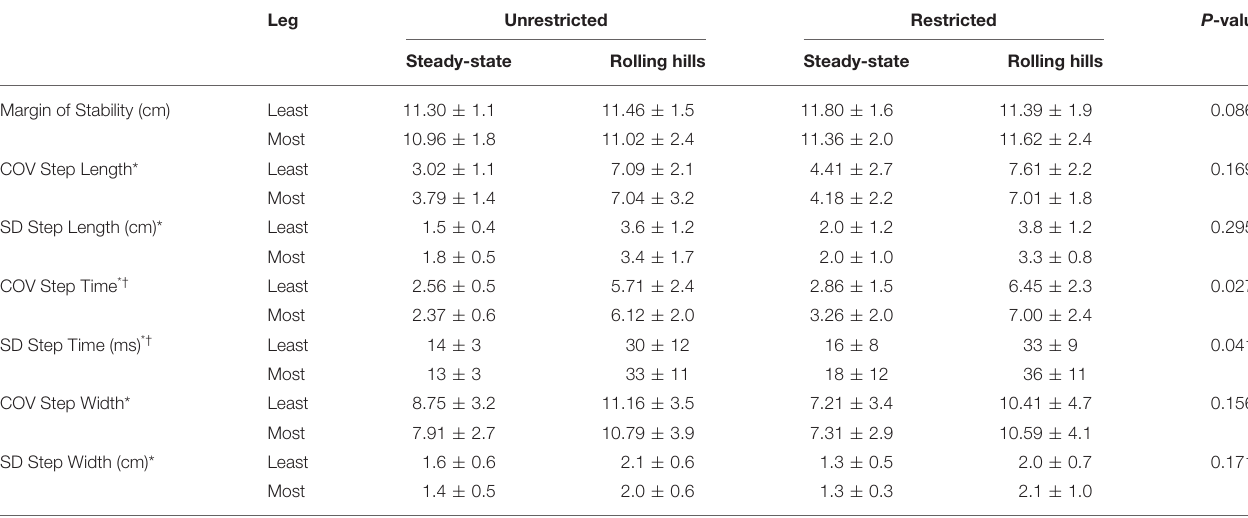
TABLE 2A | Dynamic Stability Measures for arm (unrestricted and restricted) and terrain (steady-state and rolling hills) conditions: Margin of Stability and Coefficient of Variation for Step Time, Length, and Width along with spatiotemporal averages. Leg